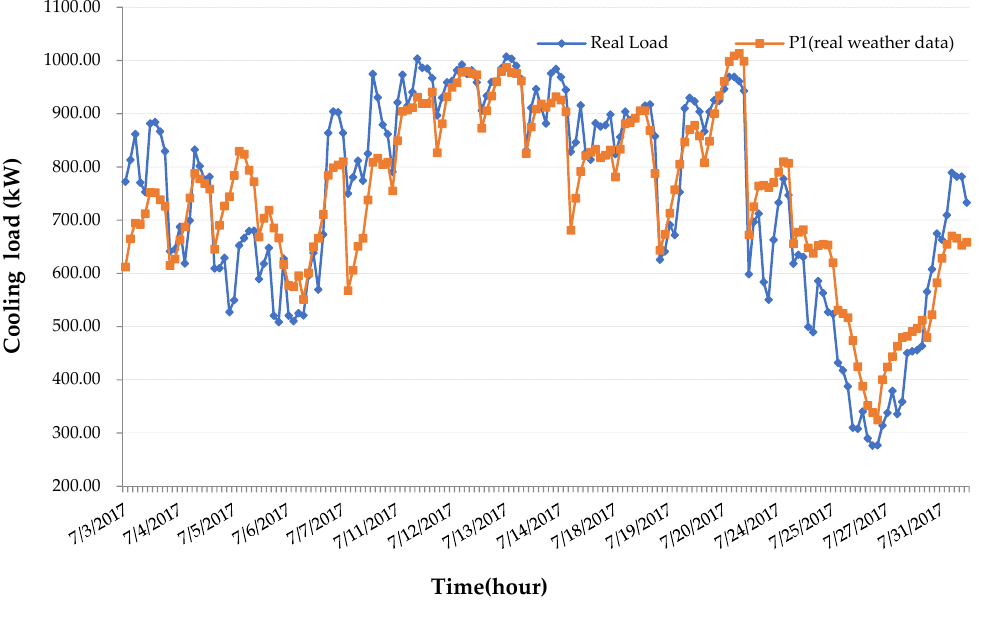
Figure 7. Comparison between the real load and forecast load P1. P1 is the forecast load adopting real weather data using the SVM model.